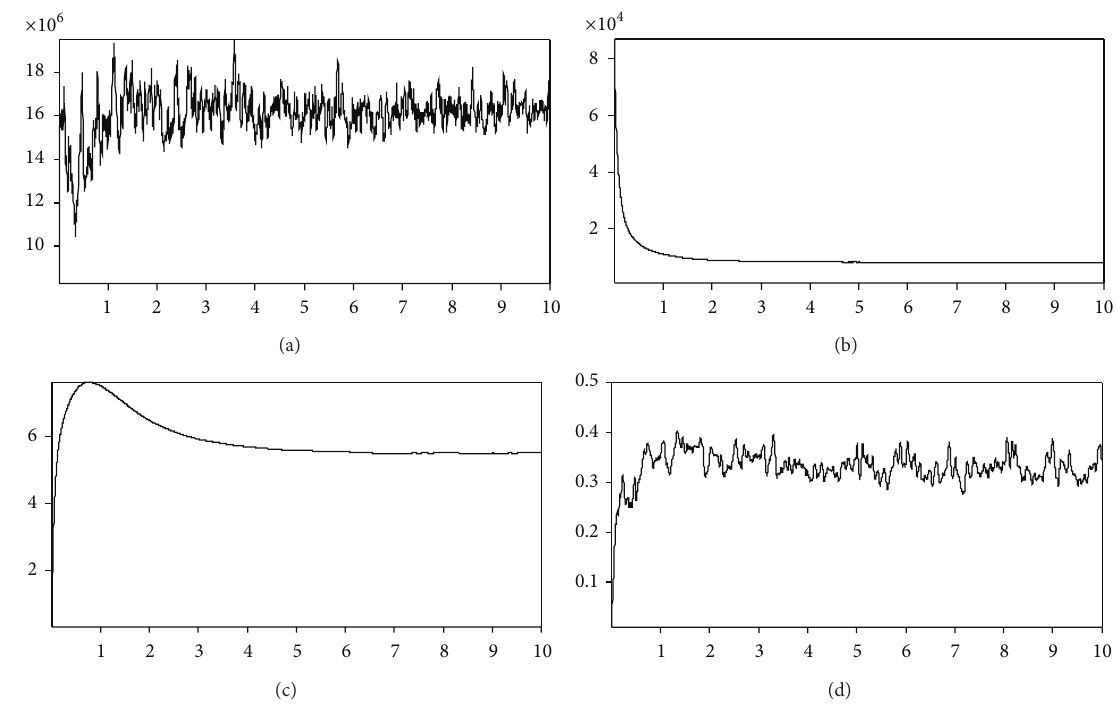
Figure 8: Time series of RMSEs of (a) atmospheric stream function, (b) oceanic stream function, (c) sea surface temperature, and (d) land surface temperature for the assimilation